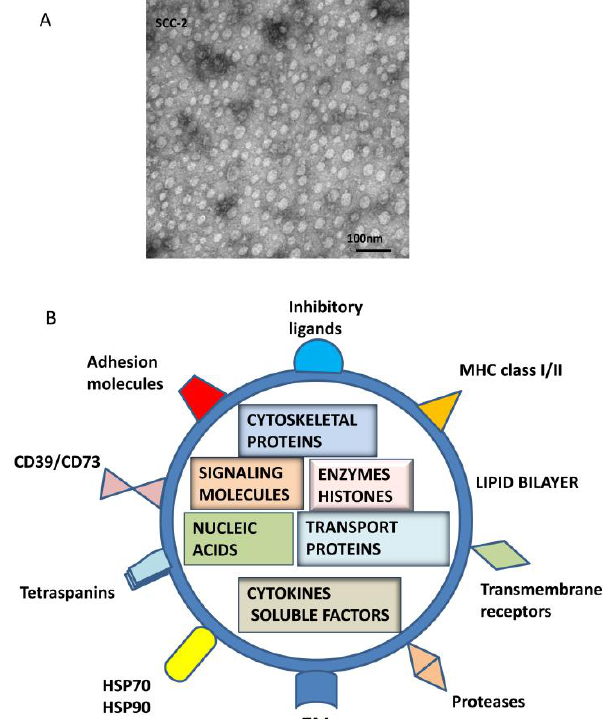
Figure 1. TEX morphology and composition. In ( A ), Transmission electron microscopy (TEM) image of TEX isolated by mini-SEC from a supernatant of a head and neck squamous cell carcinoma (HNSCC) cell line, PCI-13. Courtesy of Dr. Sonja Funk. TEX look exactly like other exosomes isolated from cancer patients’ plasma [11]. In ( B ), a schematic summarizing molecular and genetic contents of TEX surface membrane and lumen is presented. In the lumen, nucleic acids include DNA, mRNA and miRNA; cytosolic protein include various enzymes; soluble factors, such as PGE 2 ; cytokines; histones; transport proteins such as ALIX, Rabs, dynamin, LAMPs; cytoskeletal proteins, including actin, tubulin, vimentin and others; oncoproteins; and a variety of signaling molecules, including MAPK, ERK1/2, Rho, catenin, Wnt and many others. The surface membrane of TEX is a lipid-protein bilayer that contains cholesterol, ceramides, sphingomyelins and phospholipids as well as numerous biologically active proteins such as the major histocompatibility complex (MHC) molecules; TAAs; inhibitory ligands such as FasL, TRAIL, PD-L1, TGF-β/LAP; adhesion molecules notably ICAM, EPCAM, CD44, integrins; proteases such as MMPS and CD26; ectonucleotidases engaged in adenosine production, CD39/CD73; transmembrane, receptors such as CXCR4 and c-Met; heat shock proteins (HSPs); and numerous tetraspanins frequently used as “exosome markers.”